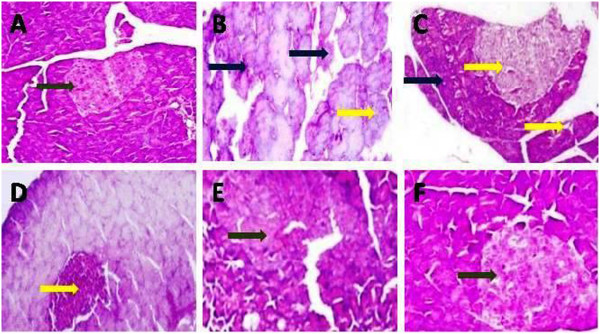
Paederia Foetida Linn. leaves extract effect on pancreas histopathology in normal and STZ induced diabetic rats. (A) Normal control: Normal control group rat histopathology display the normal size of islet of langerhans (Green arrow) (B) Diabetic control: Diabetic control histopathology display the focal necrosis (yellow arrow) and bigger in the size of islets of langerhans (Black arrow). (C)PF I (100 mg/kg): PF tested drug display bigger size of islet (Black arrow) and focal necrosis (Yellow arrow). (D)PF II (250 mg/kg): PF tested drug display only focal necrosis (Yellow arrow) (E)PF III (500 mg/kg): PF tested drug display normal size of islet (Green arrow) (F) Glibenclamide (10 mg/kg): Glibenclamide treated rat pancreas showing normal islet (Green arrow). For each group 6 rats were examined and 50 pictures were taken. Original magnification, 10×.